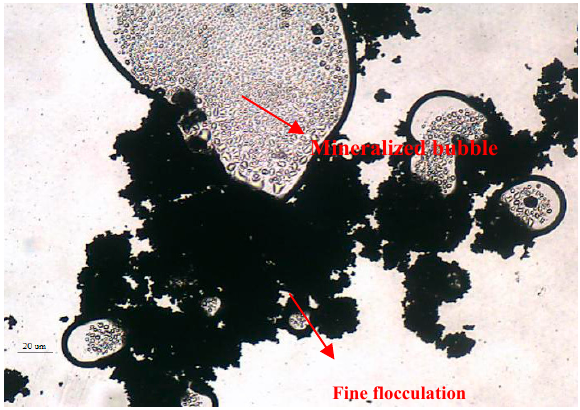
Figure 9. Analysis of mineralized bubble by microscope imagine.